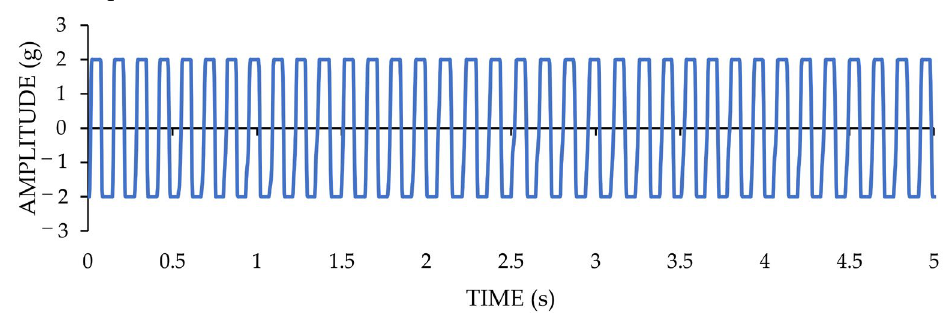
Figure 9. The time-domain presentation of acceleration amplitude saturation of LARA.